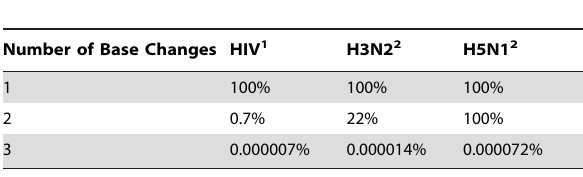
Table 1. Probability of Generating all Possible 1-, 2-, or 3-Base Mutations in HIV or Influenza